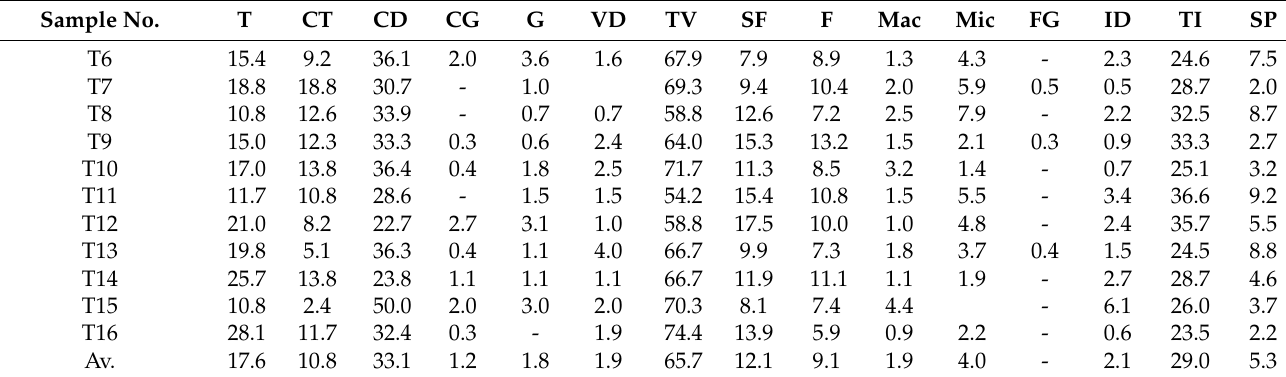
Table 3. Quantification of macerals in unaltered coal (vol. %).